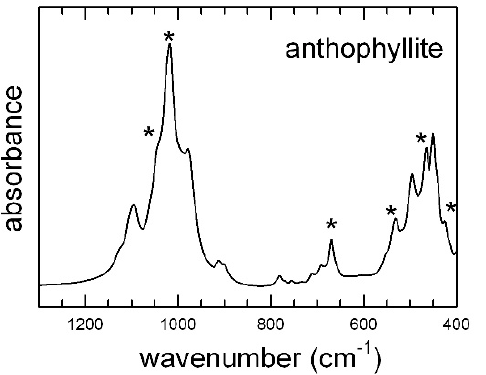
Figure 8. FTIR spectrum of UICC anthophyllite in the low-frequency (1300–400 cm − 1 ) region. The asterisks indicate the main bands of talc [45].